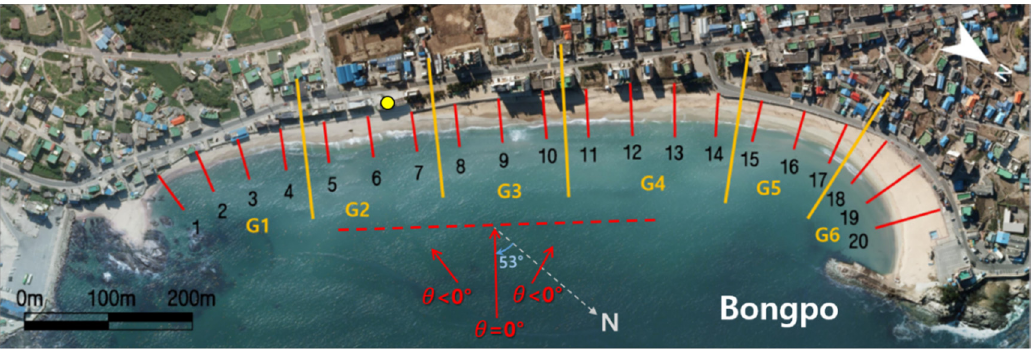
Figure 2. Cluster tree of beach width data resulting from hierarchical clustering.